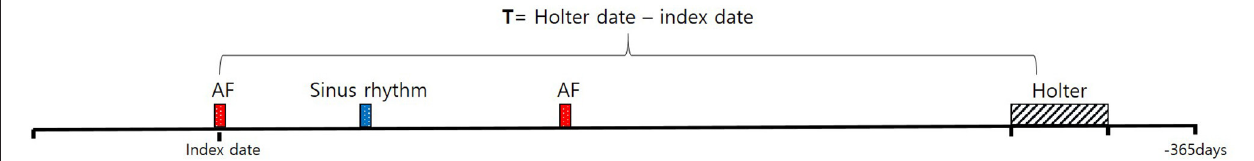
FIGURE 1 | Flow chart.